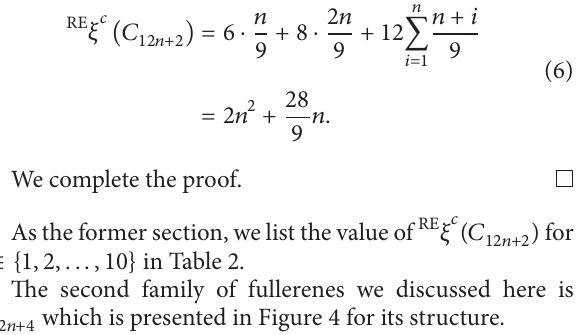
details on the structure of fullerenes and their engineering applications.